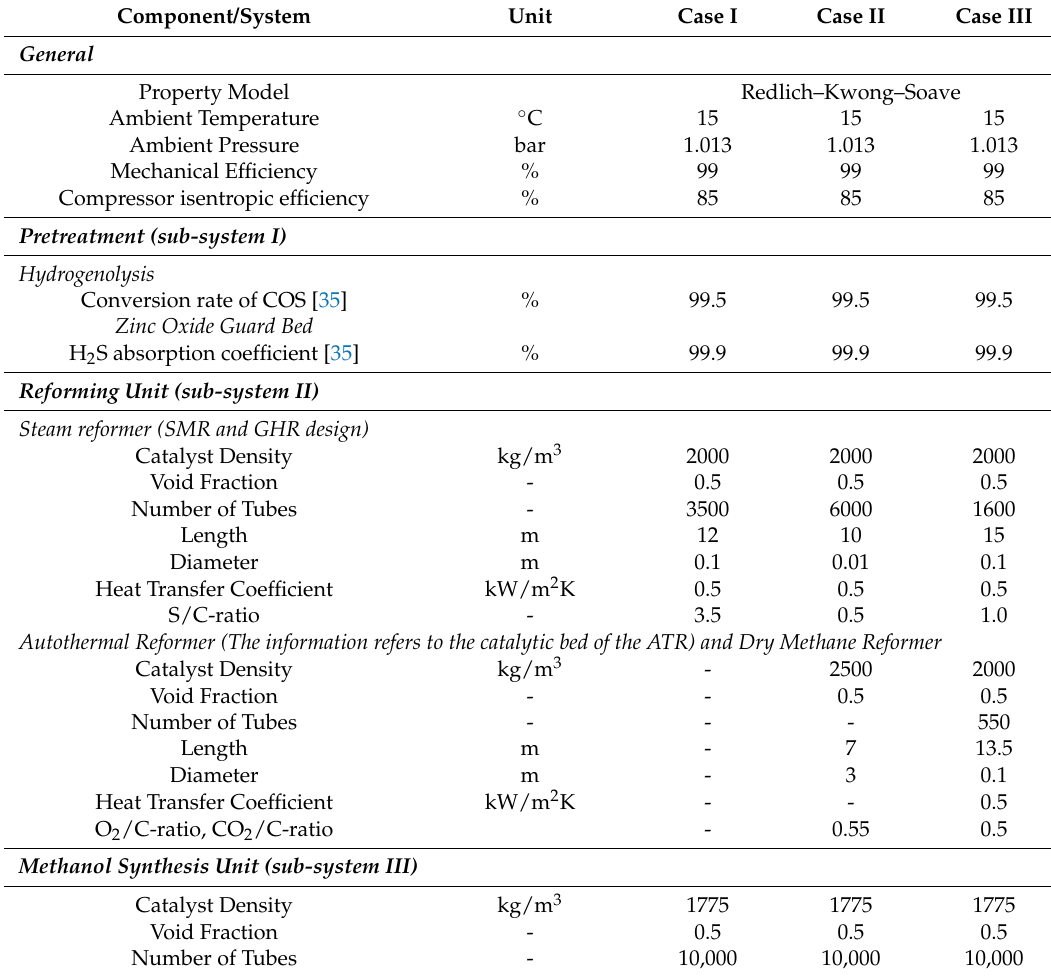
Table 2. Overview of major assumptions made for modeling the plant designs in Aspen